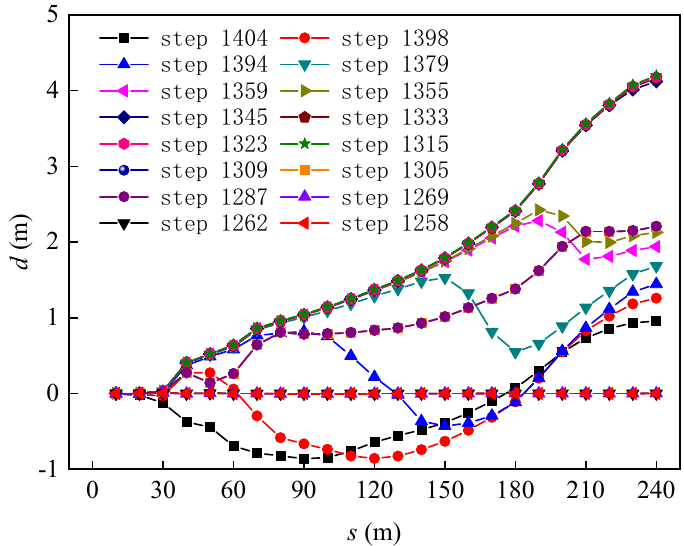
Figure 6. Relation between the horizontal displacement of steps and working face advancement.